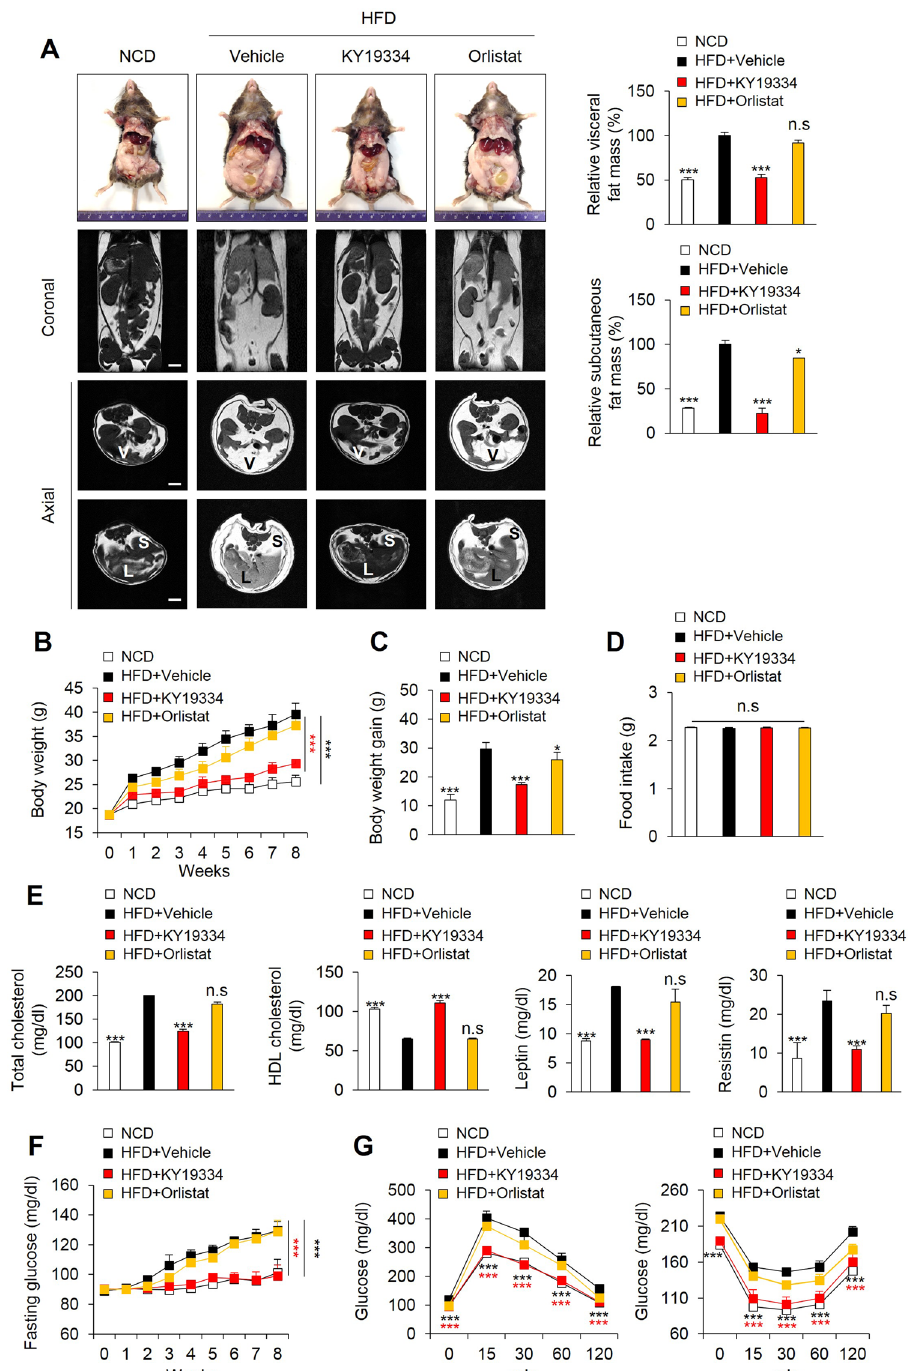
Figure 2. KY19334 treatment prevents diet-induced obesity and insulin resistance. C57BL/6 mice fed the NCD or HFD were orally administered with KY19334 or Orlistat concentration at 25 mg/kg/day for 8 weeks ( n = 6 per group). ( A ) Representative photographs (upper panel) and MR images of mice (lower panel). Visceral and subcutaneous fat were quantified ( B ) Body weight changes. ( C ) Body weight gain ( D ) Daily food intake during all study weeks (mean ± SD., n.s indicates non-significance with HFD-fed vehicle group). ( E ) Plasma concentration of total cholesterol, HDL-cholesterol, leptin, and resistin in the overnight fasted state. ( F ) Fasting glucose. ( G ) Glucose and insulin tolerance test. Scale bar, 100 µm. Results are expressed as mean ± SD., n = 3 per group, * P < 0.05, *** P < 0.001, n.s indicates non-significance with HFD-fed vehicle group. NCD normal chow diet, HFD high-fat